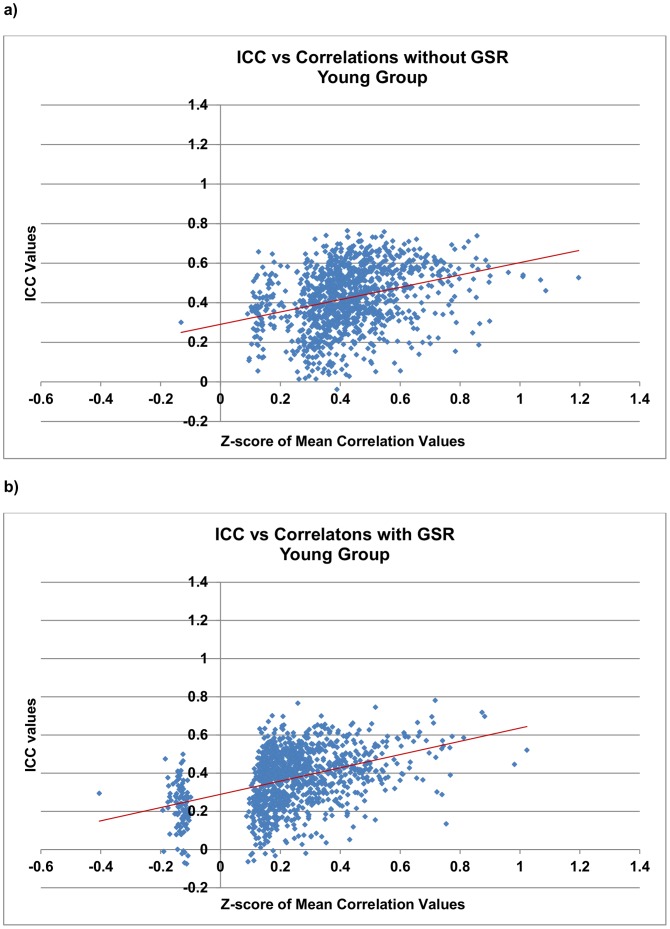
Reliability of RSFC vs. magnitude of functional connections in the young group.A left shift of data points indicates a reduction in the magnitude of functional connections when GSR is applied. The Wilcoxon signed-rank test shows reduced ICC values when GSR is applied (p-value <0.0001). Each data point represents a correlation that is significant both with and without GSR. Linear regression fits were overlaid on the data.